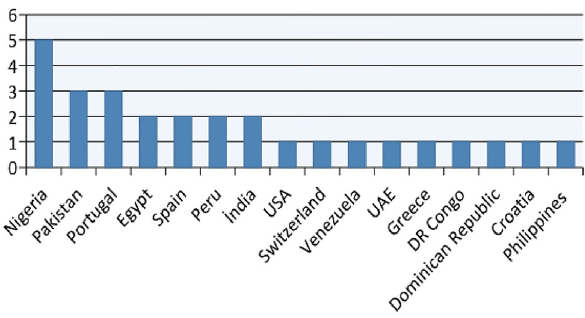
Figure 1: Distribution of participant